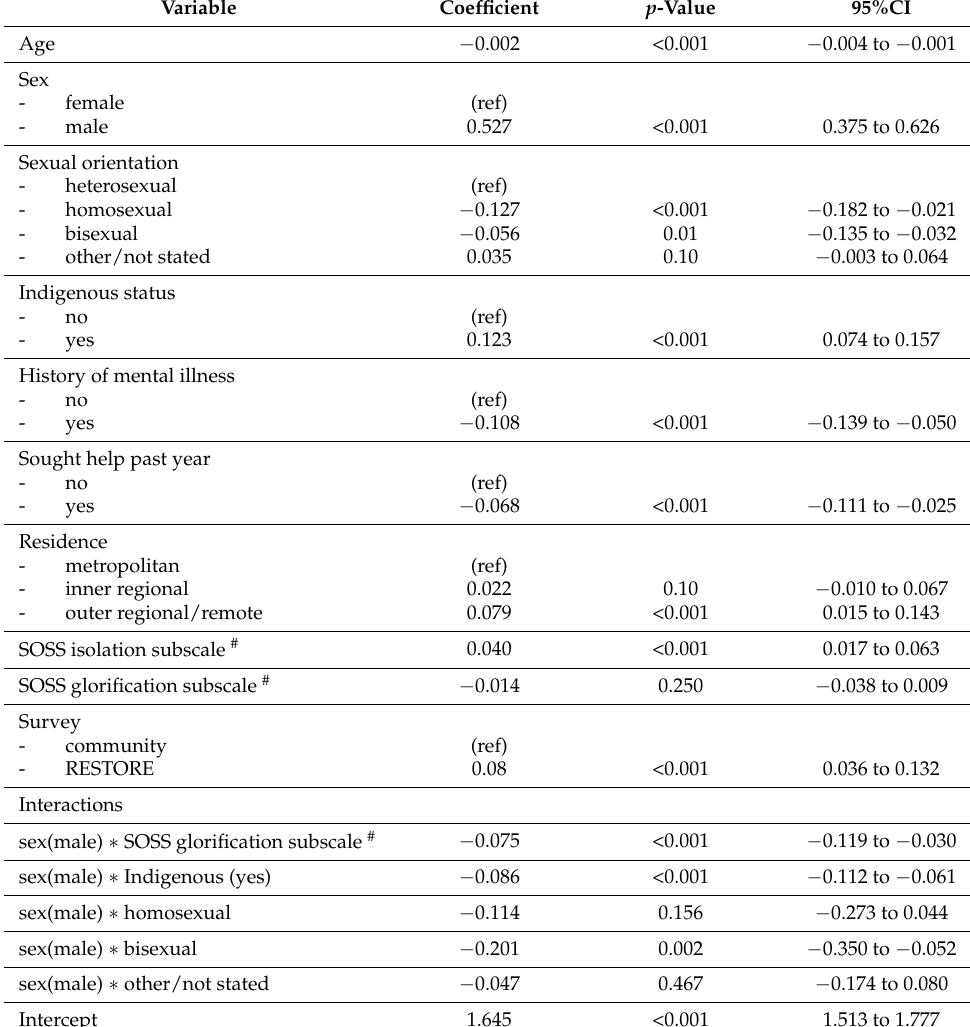
Table 3. Multivariate linear regression model of factors significantly associated with the SOSS suicide stigma subscale. Variable Coefficient p -Value